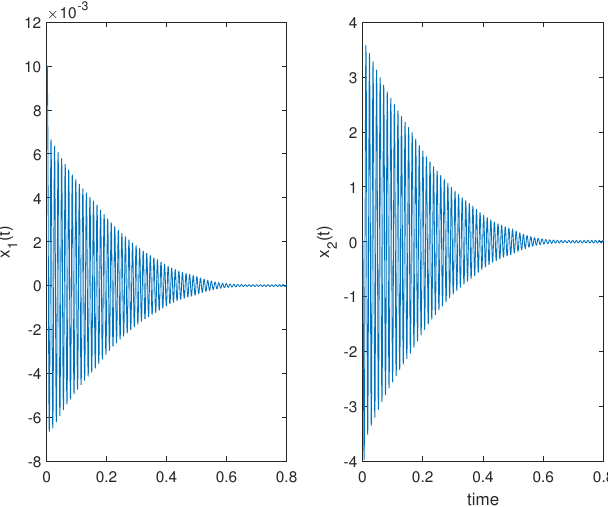
Figure 5. State trajectories of the state vector X ( t ) of Case